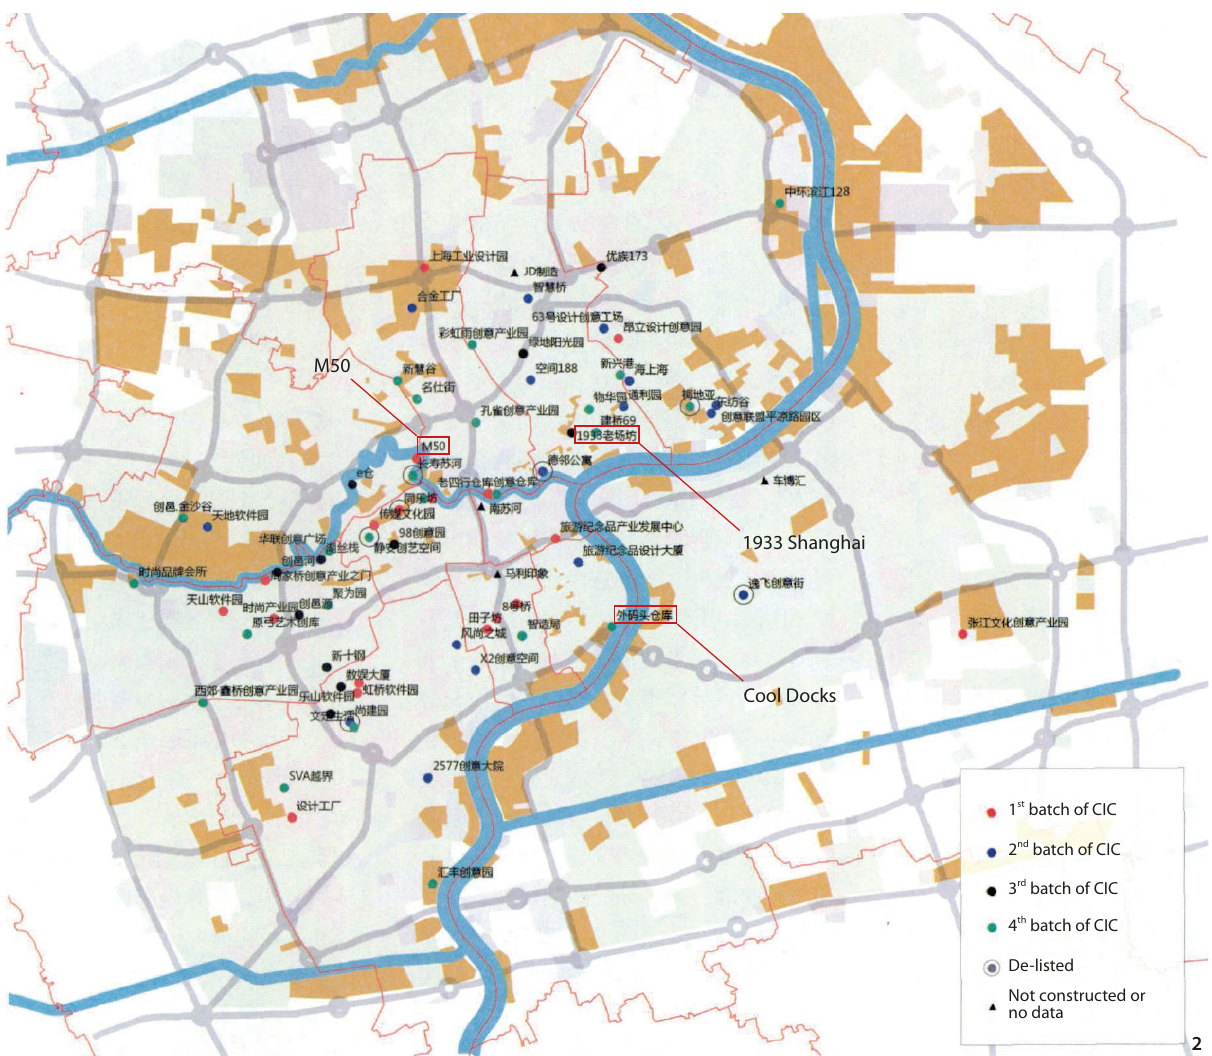
Figure 2 The map of first four batches of CIC designation with 3 study cases highlighted (Source: Luan, Wang, and An